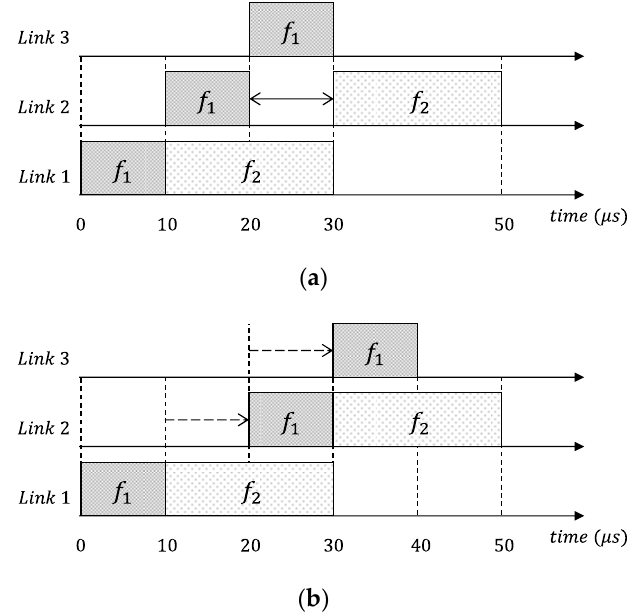
Figure 5. Cases where schedule compression is not possible: ( a ) before compression and ( b ) after compression.